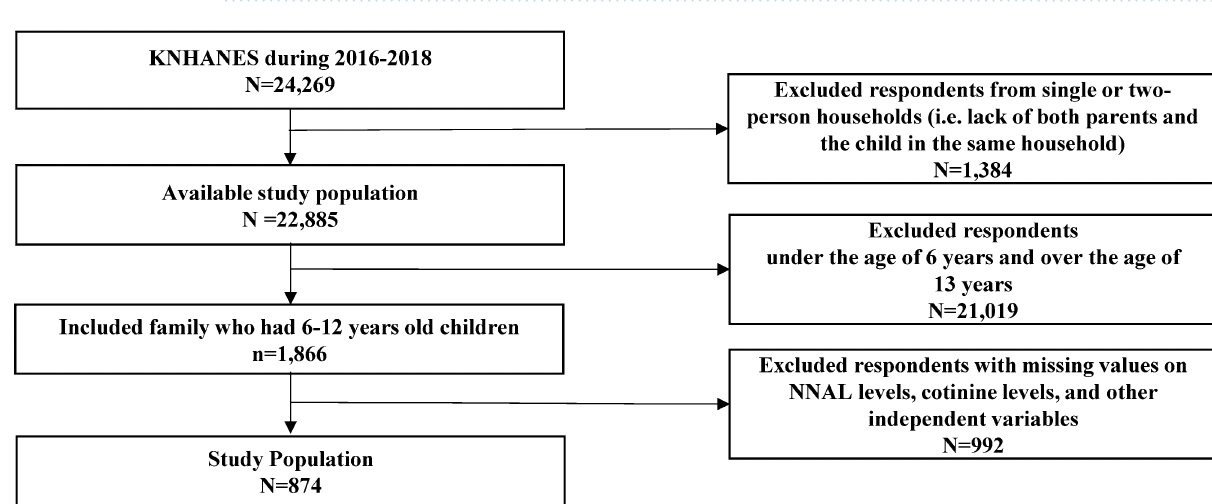
Figure 1. Association of children’s 4-(methylnitrosamino)-1-(3-pyridyl)-1-butanol (NNAL) and cotinine concentrations with the number of cigarettes smoked by the parents ( a ) and smoking pattern ( b ). Adjusted for children’s sex, age, body mass index, secondhand smoke exposure (house), and secondhand smoke exposure (public), and for parents’ household income, type of housing, region, age, education level, private health insurance, drinking status, and year of evaluation. The reference group is the group of parents who are non- smokers.